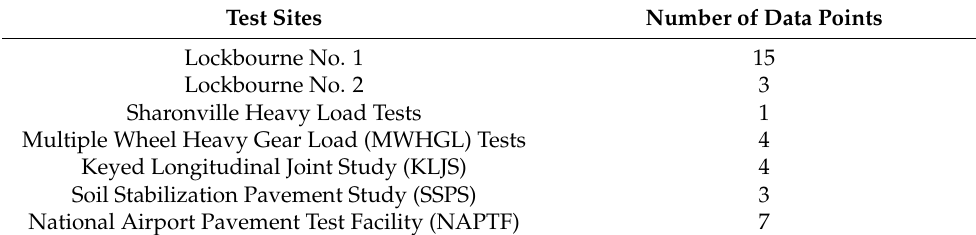
Table 1. The full-scale test data used for the regression analysis in the fatigue model of FAA.